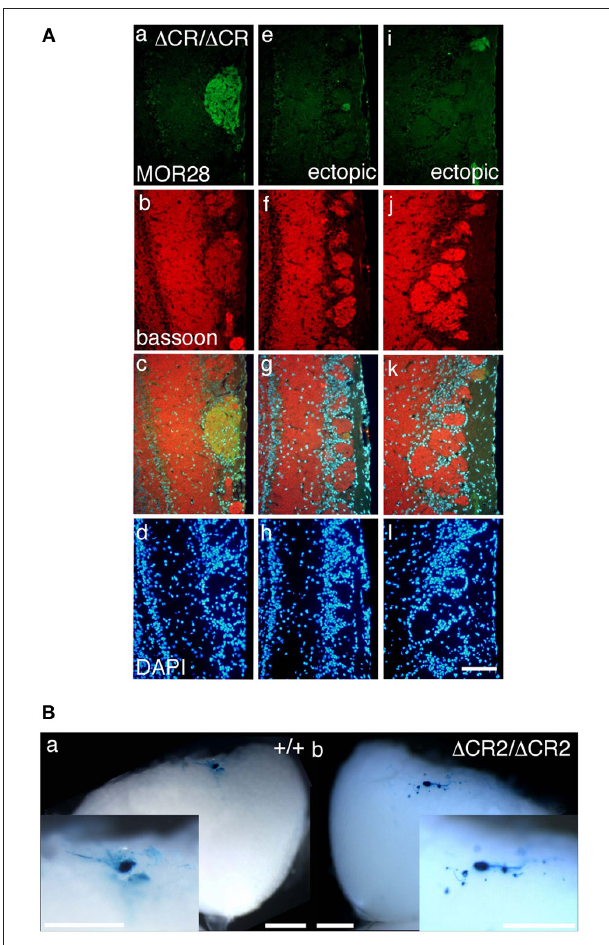
FIGURE 1 | Ectopic glomeruli in MOR28 and P2 OSN projections. (A) Representative examples of the lateral side of three MOR28 glomeruli, (a: one innate glomerulus, e and i: two small ectopic glomeruli). (b, f, and j) Immunoreactivity for bassoon (a presynaptic active-zone protein) was observed in all the MOR28 glomeruli in the Pcdha (cid:2) CR /(cid:2) CR mice. (c, g, and k) merged images. (d, h, and l) DAPI. Scale bar, 100 μ m. (B) Lateral P2 glomeruli in whole-mount OBs from WT (a) and Pcdha (cid:2) CR 2 /(cid:2) CR 2 (b) mice at P7. In the Pcdha (cid:2) CR 2 /(cid:2) CR 2 mice, small ectopic glomeruli were observed near the large main glomerulus. Scale bars, 500 μ m.